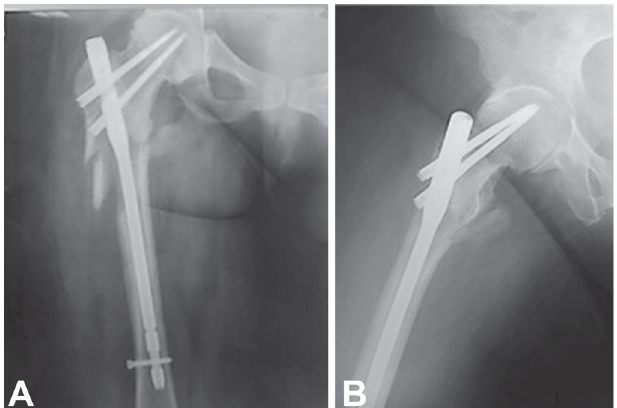
Figure 2. (A) Anteroposterior radiograph of the right hip of an 80-year-old woman with an unstable pertrochanteric fracture (reverse oblique, AO/OTA 31A3.3) of the left hip treated with long intramedullary hip nail. (B) Lateral radiograph of the right hip at 3-month follow-up shows fracture healing; the patient was weight-bearing with a